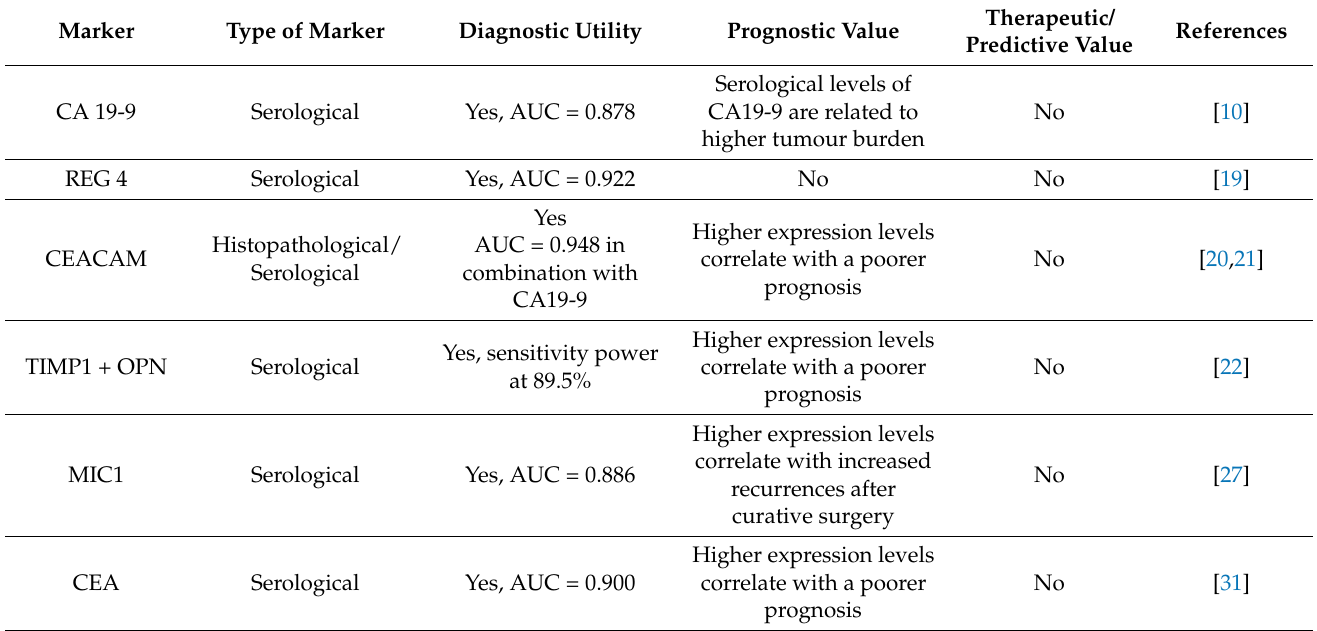
Table 1. A summary of the main biomarkers in pancreatic adenocarcinoma. Diagnostic Utility Prognostic Value